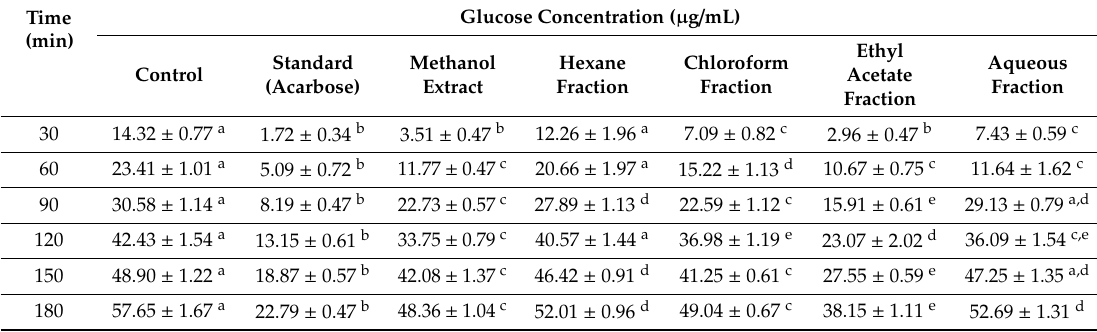
Figure A3. Dose–response relationship of methanol extract and its fractions of G. edulis for anti glucosidase activity. Results are expressed as mean ± standard deviation ( n = 4). Table A1. E ff ect of methanol extract and its fractions of Gracillaria edulis (1000 µ g / mL) on glucose di ff